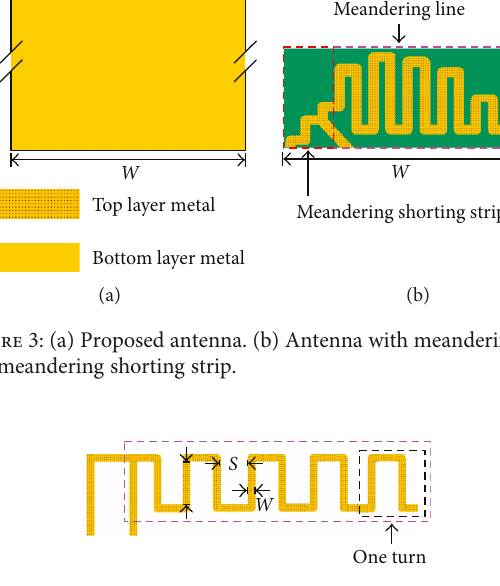
Figure 4: Meandering line used in PIFA.